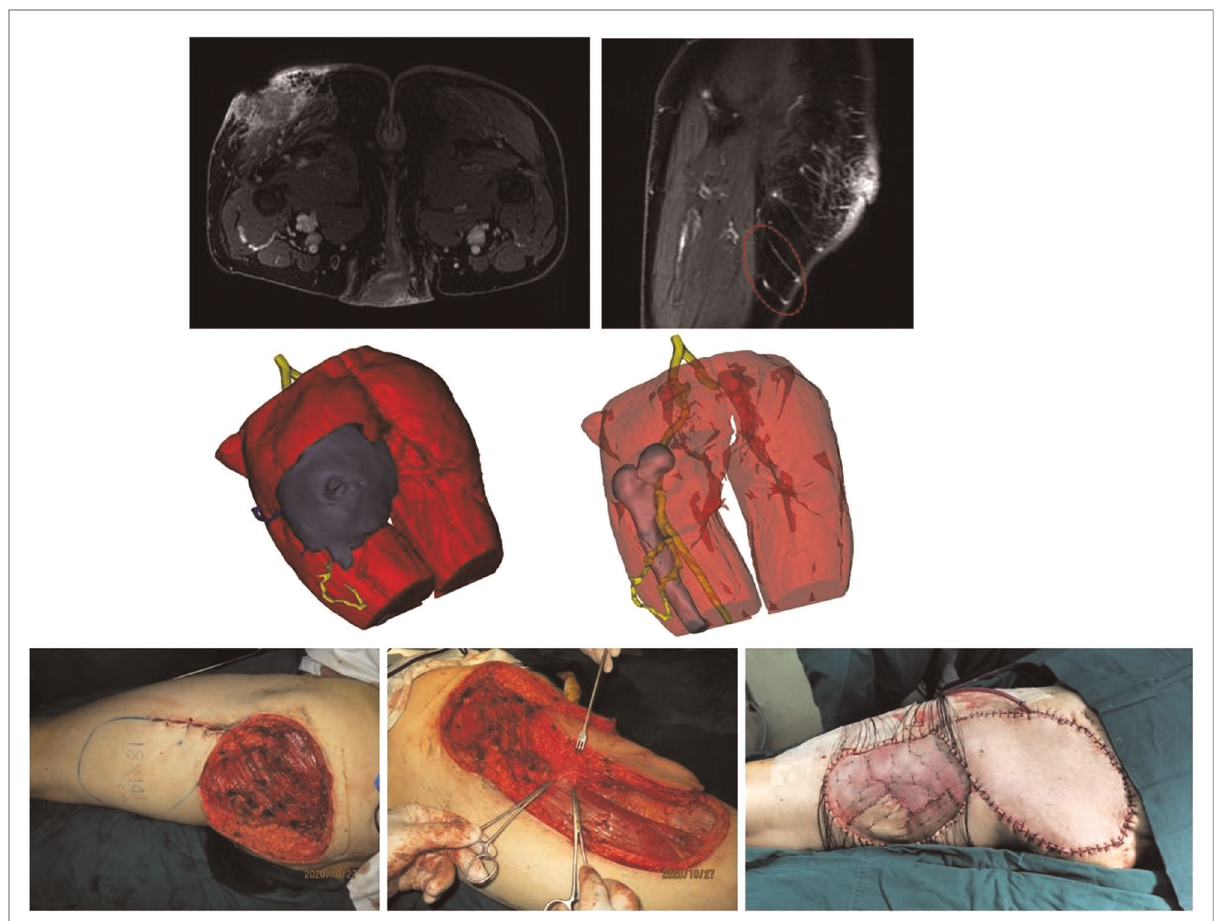
FIGURE 5 (Above) preoperative MRI showing the tumor in fi ltrating the underlying muscle (left) and adjcent perforators (right). Red dotted line circling the preferred perforators for PPPF. (Center, left) 3DR showing the surgical anatomy involving the tumor, underlying muscle, and perforators. The PPPF was planned based on the yellow perforators. (Center, right) The yellow perforators were intact after wide excision of the tumor. (Below, left) the wound after en bloc tumor resection and the fl ap design. (Below, median) harvesting the fl ap. The clamps pointed to the perforators for PPPF. (Below, right) rotation of the fl ap for 160° to cover the wound and free skin graft to close the donor